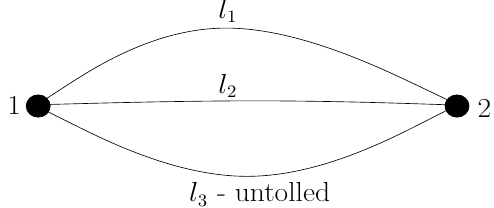
Figure 1. One origin-destination pair network with 3